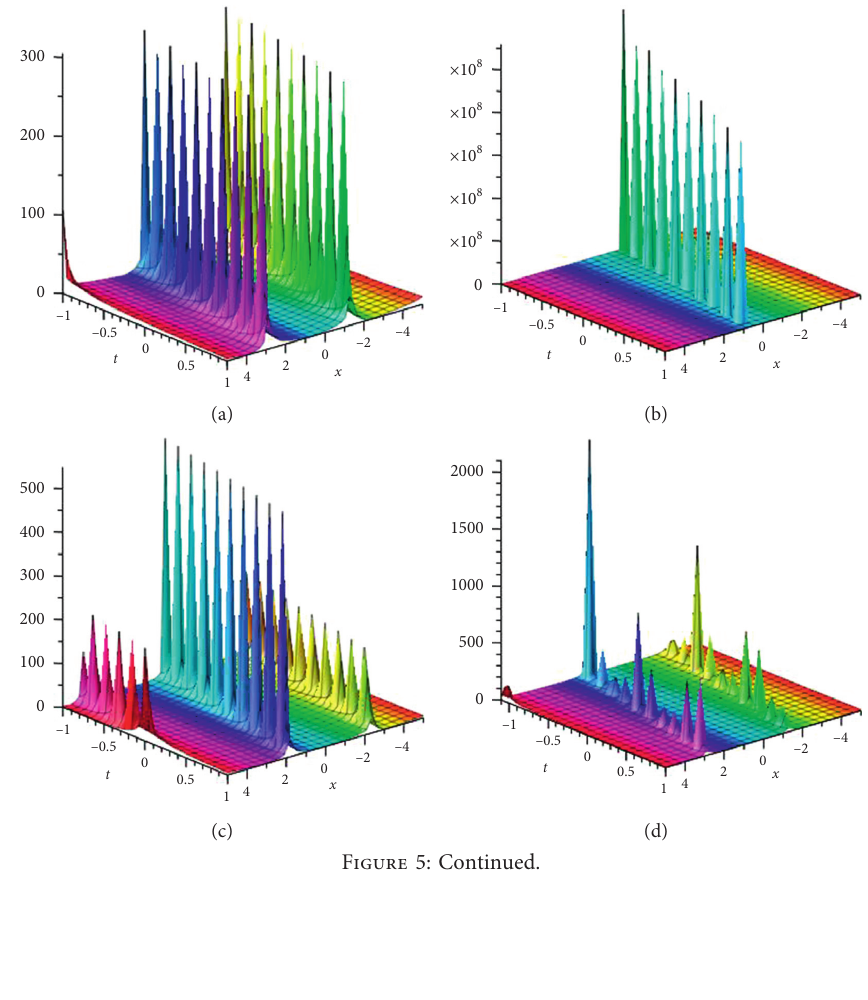
Figure 4: 3D profile of Family 16 with α � 1 . 5, β � 0, k � y � 1, ω � 0 . 5, p � q � 0 . 9, μ � 0 . 25, σ � − 0 . 75, and A � 2 . 5. (a) | Φ | . (d) | Φ | . (e) | Φ | (c) | Φ 18 19 20